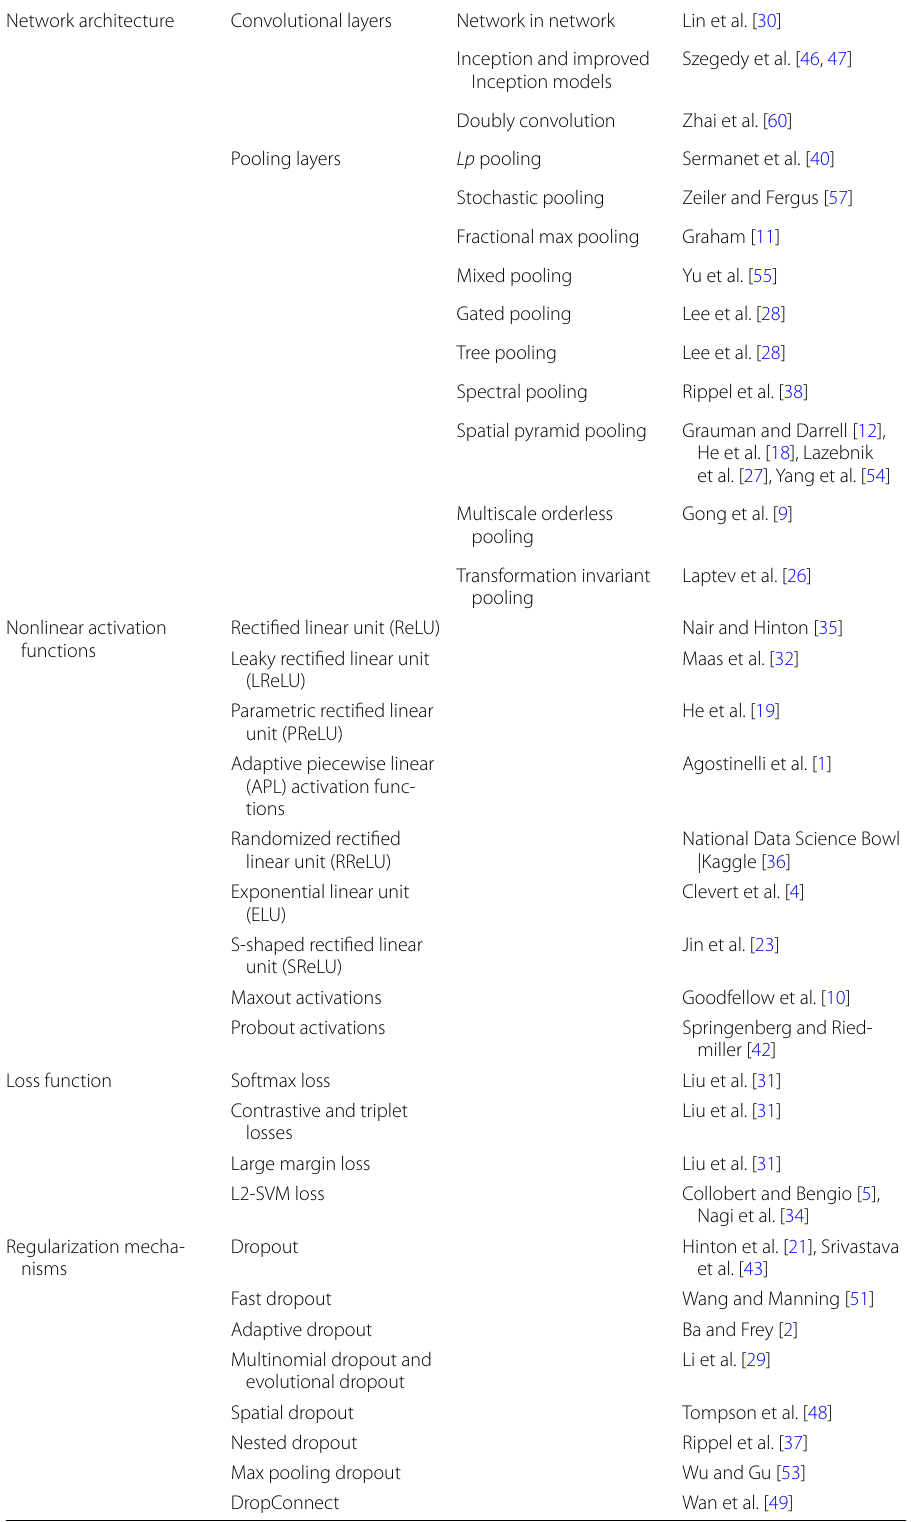
Table 1 Some recent attempts to improve different aspects of CNNs Network